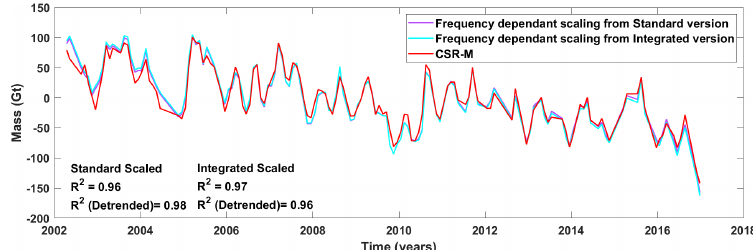
Figure 16. Comparison of basin-averaged time series from frequency-dependent scaling of GRACE SH using standard and integrated WGHM with basin-averaged time series from